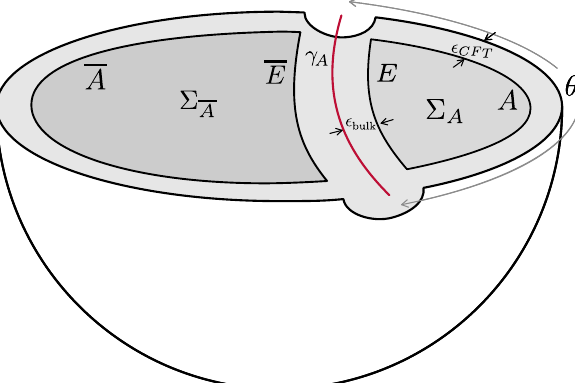
Figure 3: Bulk geometry. The complementary bulk regions are indicated by Σ Σ ¯ A and their corresponding boundary regions by A , edges on either side of the entanglement cut along the RT surface γ by E and ¯ E . The bulk cutoff is ε